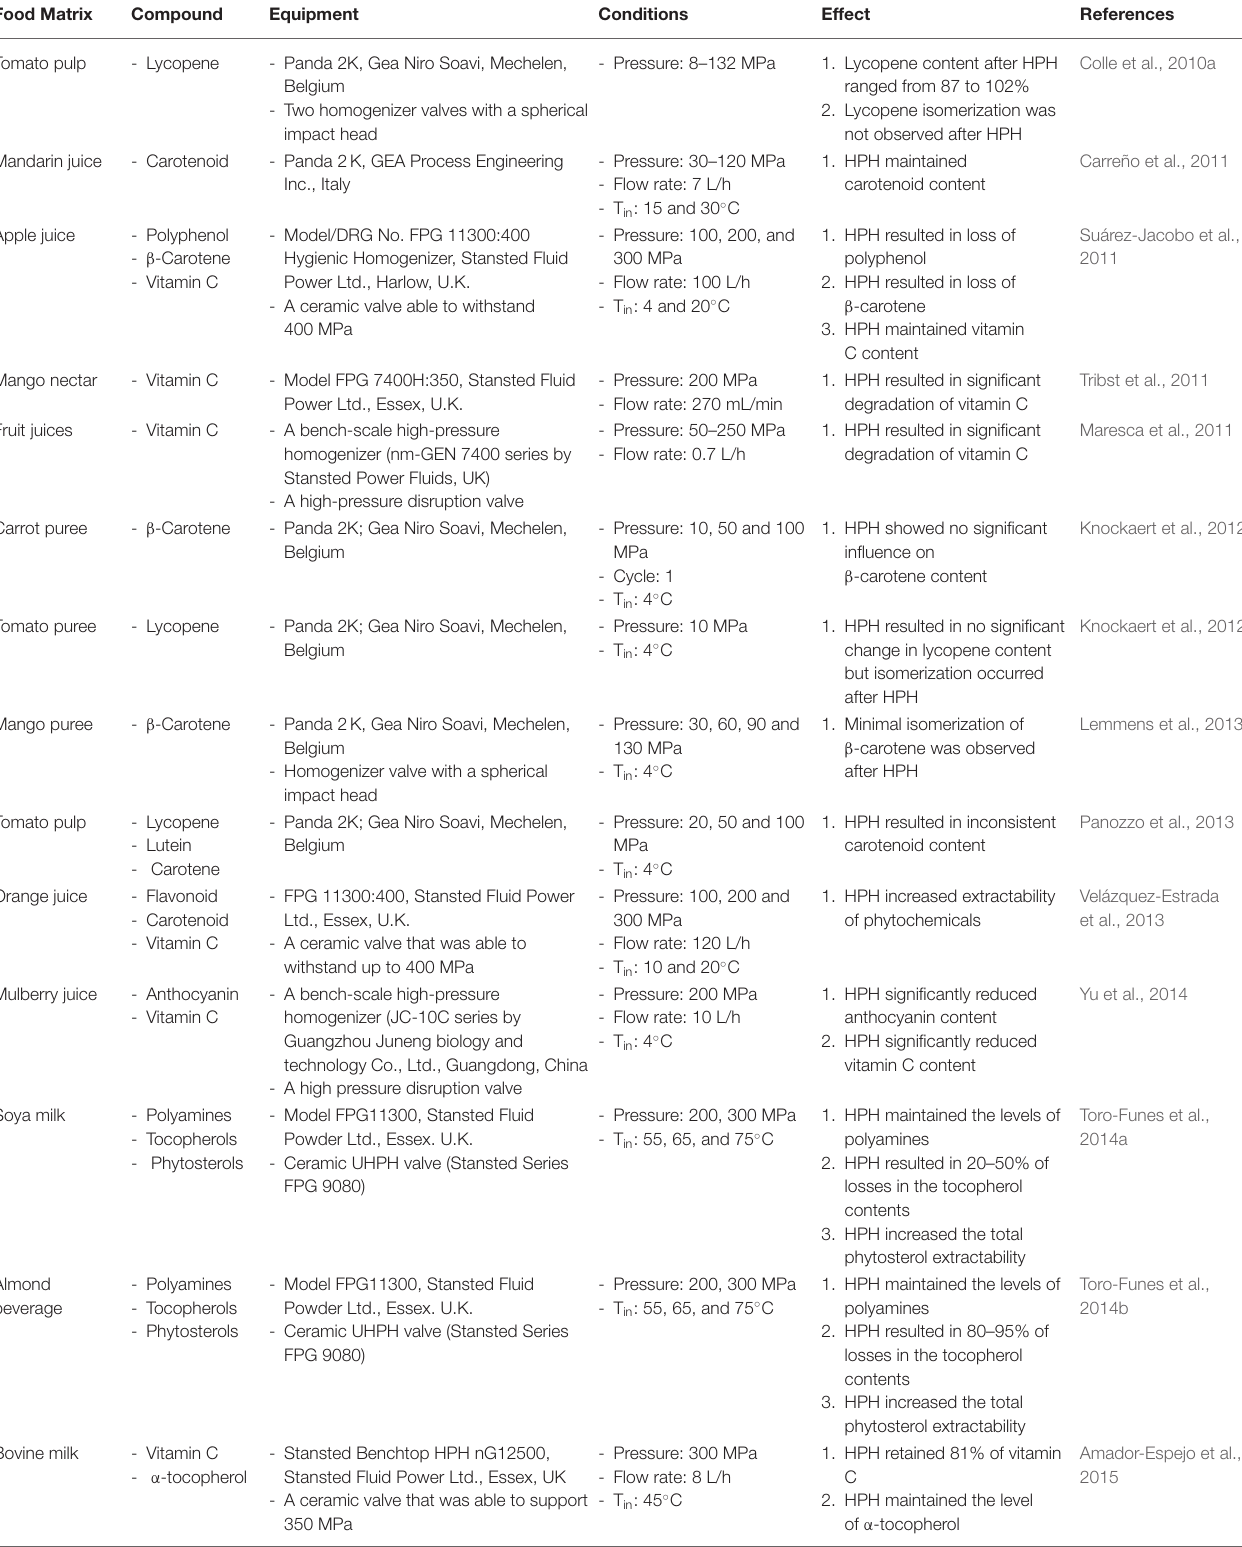
TABLE 2 | The impact of high-pressure homogenization on phytochemicals. Food